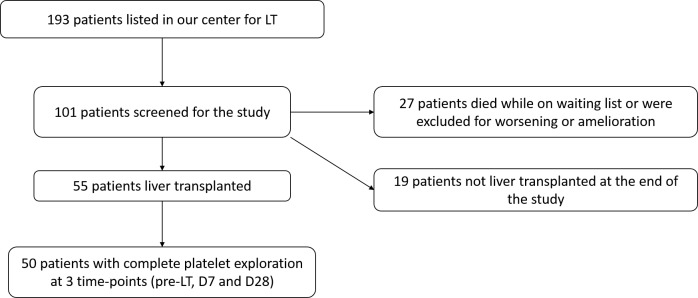
Flow chart.LT: Liver transplantation.